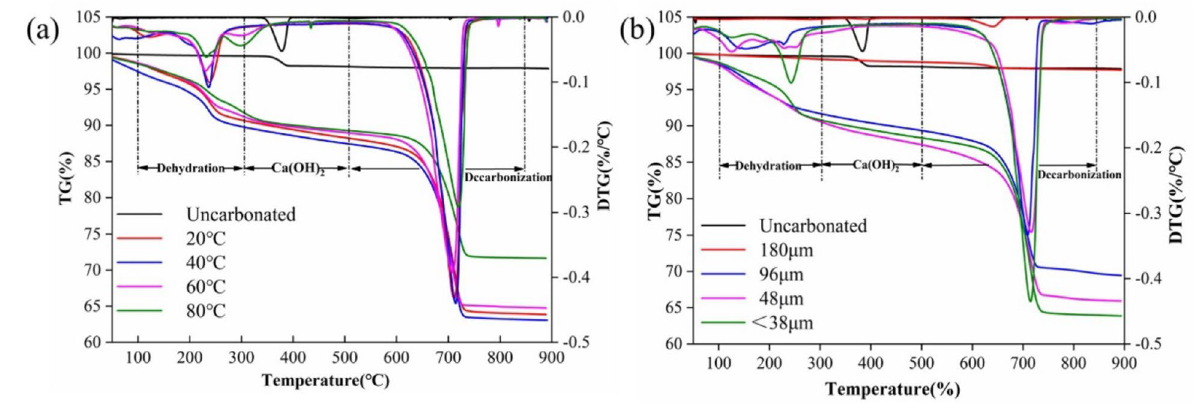
Figure 3. TG-DTG diagrams of the original LFS material and LFS samples after hydration and carbonation: ( a ) at different temperatures, ( b ) at different particle sizes. Carbonation